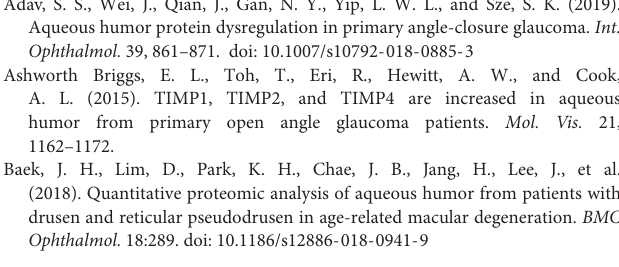
TABLE S5 | Detailed data of DIA analysis of NVG samples before and after treatment. TABLE S6 | Detailed PRM information of selected DEPs. TABLE S7 | Sheet 1. Proteins list of whole human AH, vitreous humor, tear and plasma. Sheet 2. Pathway scores (the –log10 of the Fisher’s Exact Test p -value)